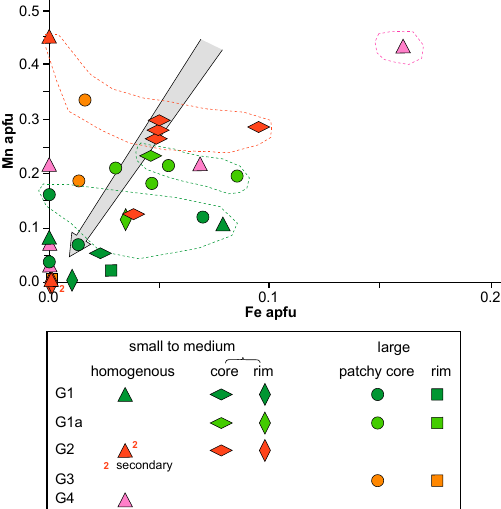
Figure 20. Mn vs. Fe diagram for Panasqueira apatite. Zoning is due to limited variations in the iron and manganese contents, with a tendency to decrease from cores to rim in the crystals. The dashed lines domains correspond to interpreted magmatic fields (pink: G4; red: G2-G3; light green G1a; green: G1). The grey arrow materializes the overall trend of subsolidus reworking towards compositions closer and closer to the pure F-apatite end-member. See the text for explanations.